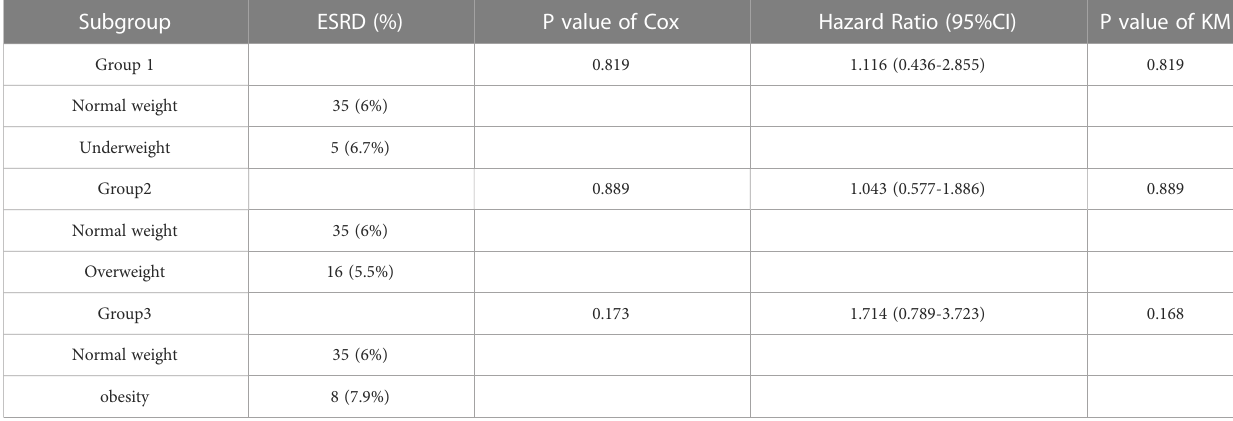
TABLE 2 The relationships between BMI and renal outcomes in the unmatched